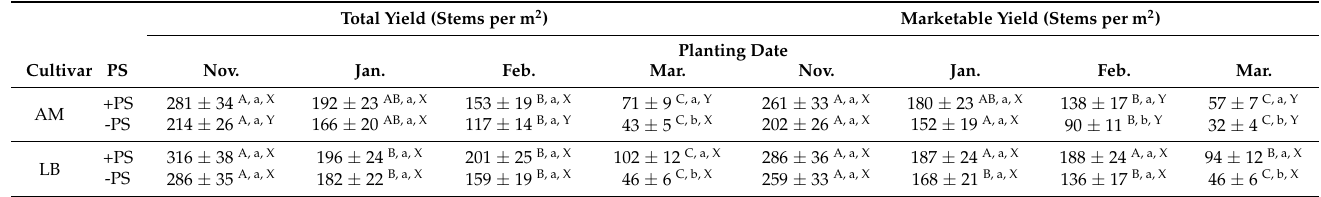
Table 2. High tunnel ranunculus production by calculated mean( ± SE) total and marketable yields in stems per m 2 by cultivars (‘Amandine’ (AM) and ‘LaBelle’ (LB)), pre-sprouting (pre-sprouted +PS and nonpre-sprouted -PS), and planting dates (Nov., Jan., Feb., and Mar.) in North Logan, UT over 2020–21 and